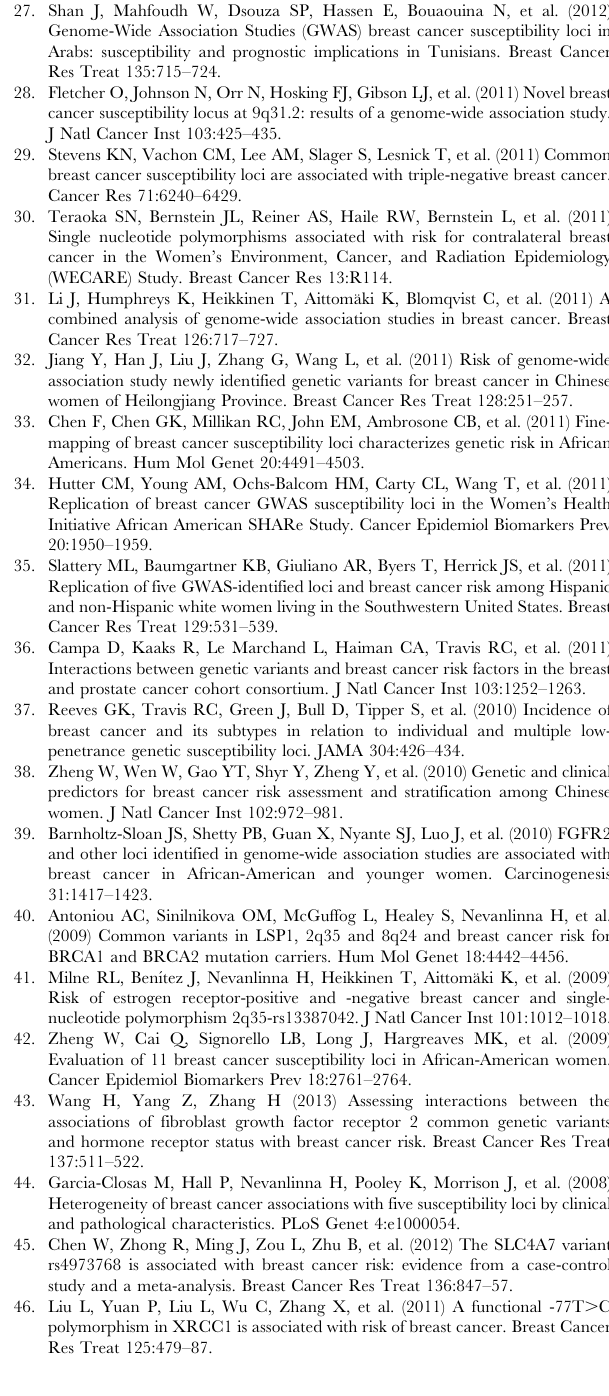
Table S1 Results of meta-analysis for 2q35-rs13387042 polymorphism and BC risk under dominant and reces- sive genetic